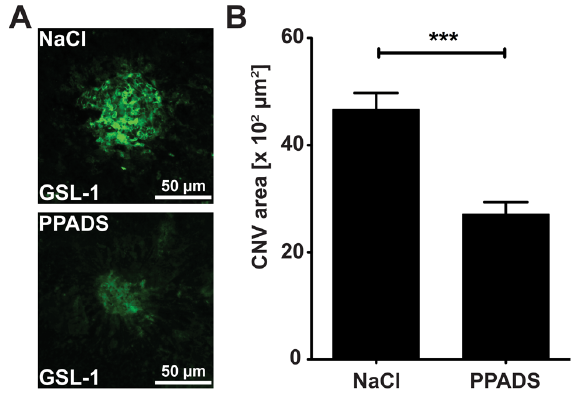
Figure 4. PPADS Inhibits Formation of laser induced CNV . A ) Representative images of GSL-1 stained CNV at day 7 post laser in a mouse eye treated with 0.9% NaCl or 4.17 mM PPADS topically for 3 days post laser. B ) Mean values 6 SEM of CNV area of 0.9% NaCl treated eyes or 4.17 mM PPADS treated eyes at 7 days post laser. Studies were performed 3 times with 5 mice in each group, n=15, NaCl=91 laser spots, PPADS=71 laser spots (*** p , 0.0005).